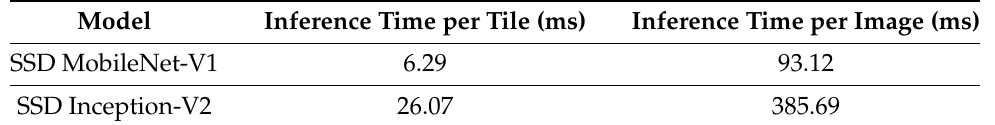
Table 6. Runtime performance of both